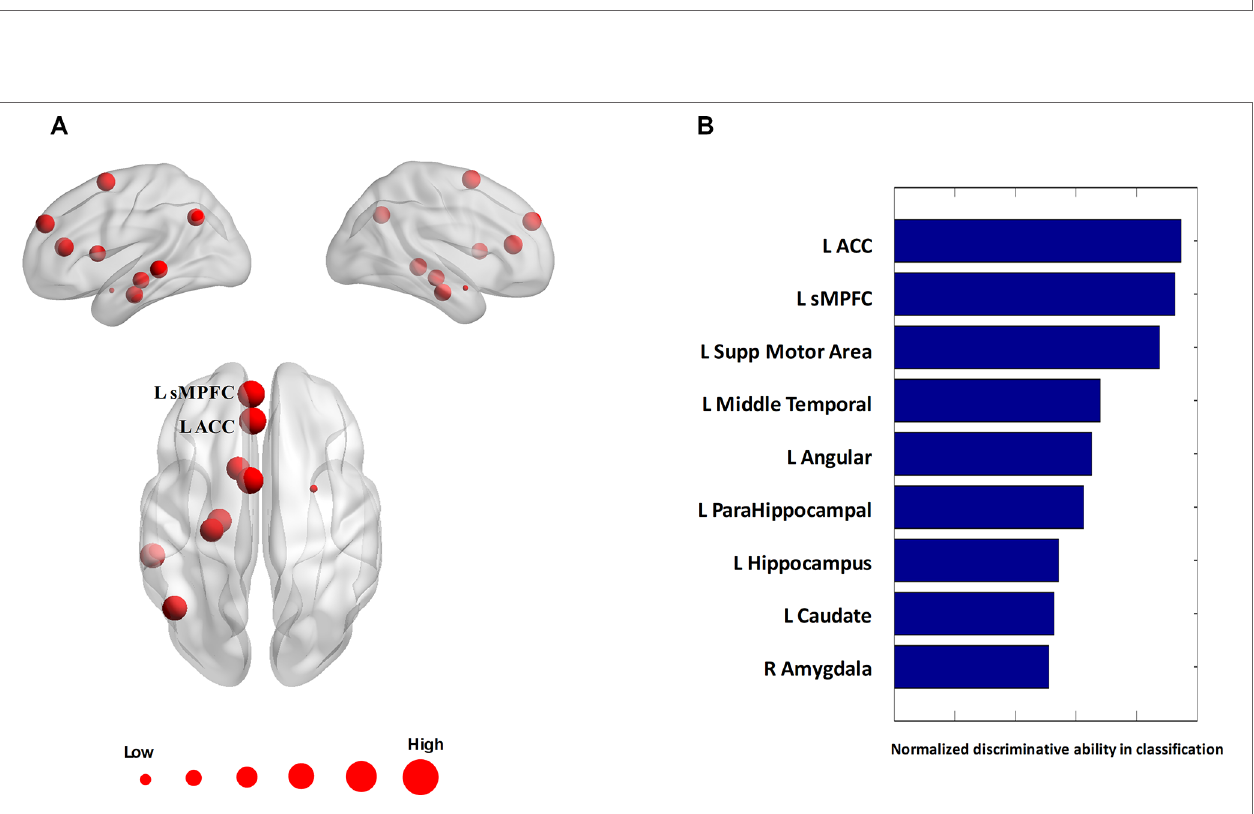
FIgURE 3 | Consensus connections. (A) The spatial distribution of the consensus connections, whose weight was scaled according to their mean discriminative power in the tenfold cross-validation. (B) The normalized discriminative ability of the consensus